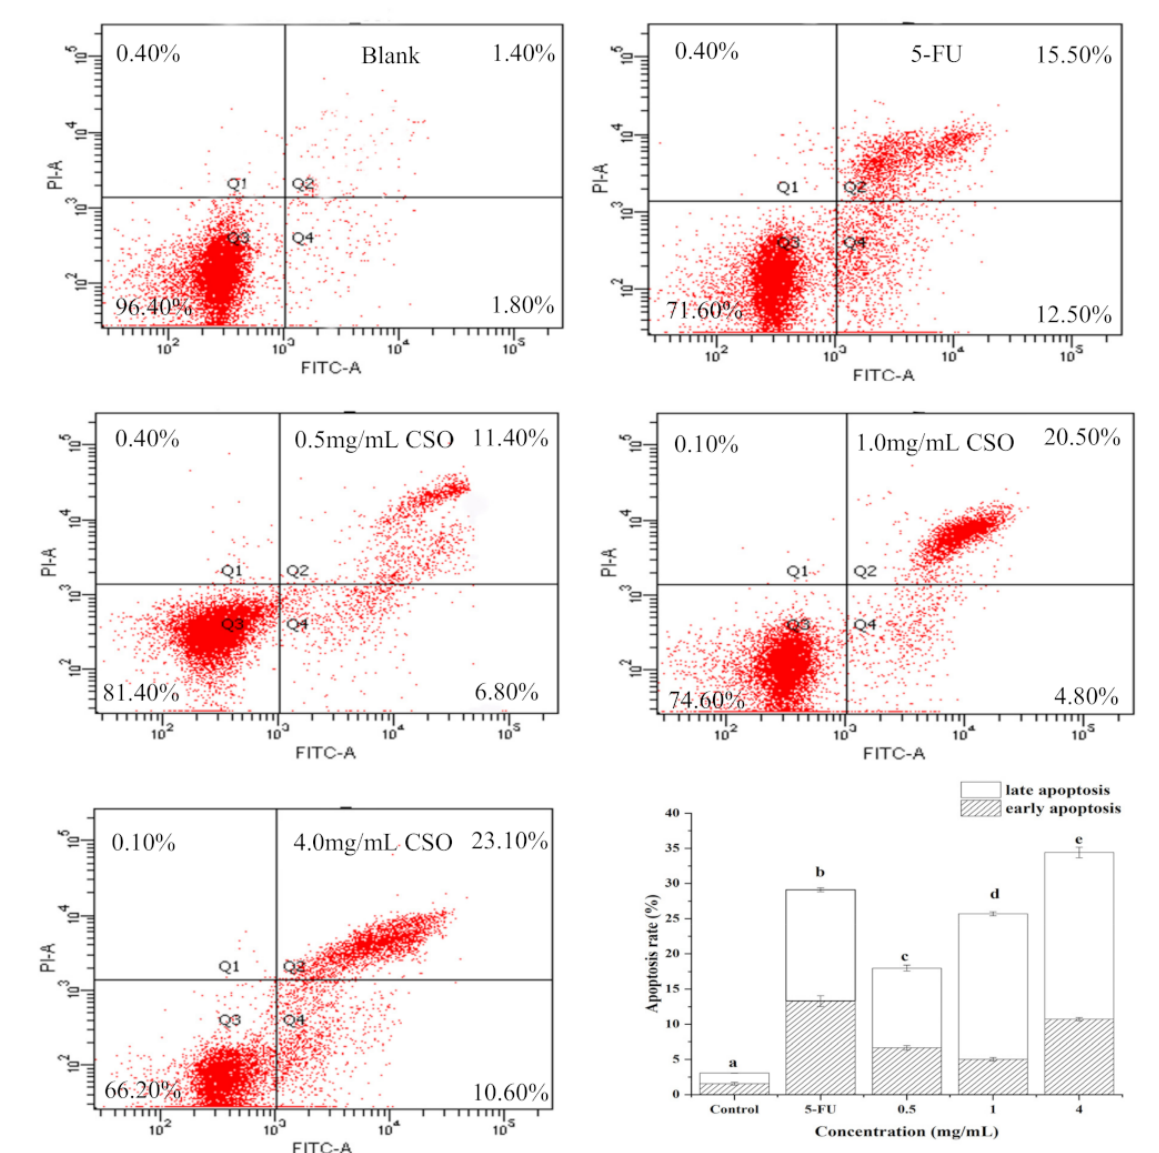
Figure 5. Cell apoptosis of HT-29 cells in the absence and presence of CSO. Different letters indicate significant differences ( p < 0.05) according to Duncan’s test. Abbreviations: 5-FU, 5-fluorouracil; CSO, coix seed